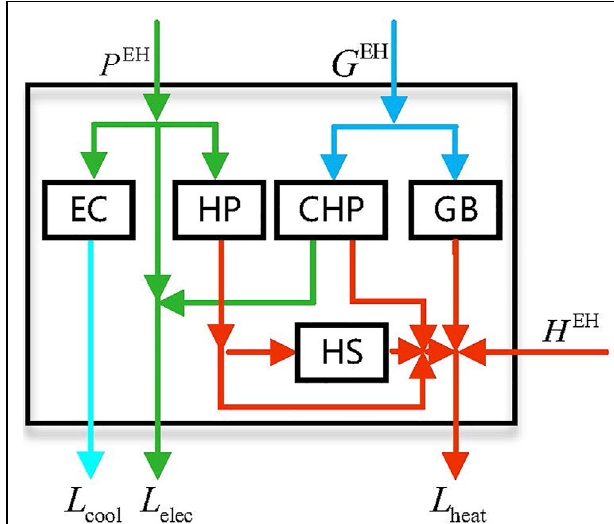
FIGURE 5 | Energy flows inside the